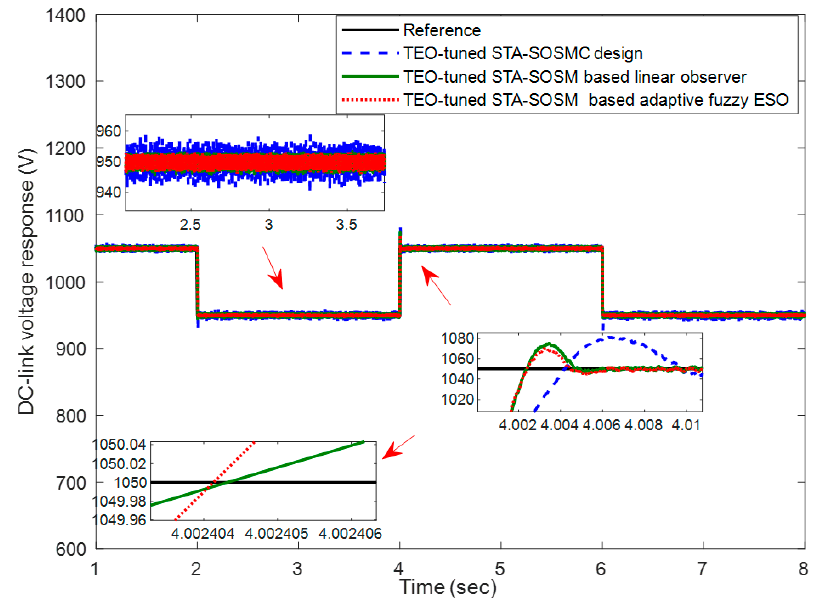
Figure 7. Time-domain performances’ comparison of the DC-link voltage. Figure 7. Time ‐ domain performances’ comparison of the DC ‐ link voltage.